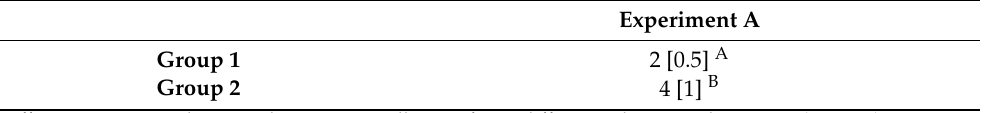
Table 2. Median [interquartile range] for experiment A (assessment of root end cavity cleanliness), acquired from retro-preparation in mandibular premolars in both groups 1 and 2.